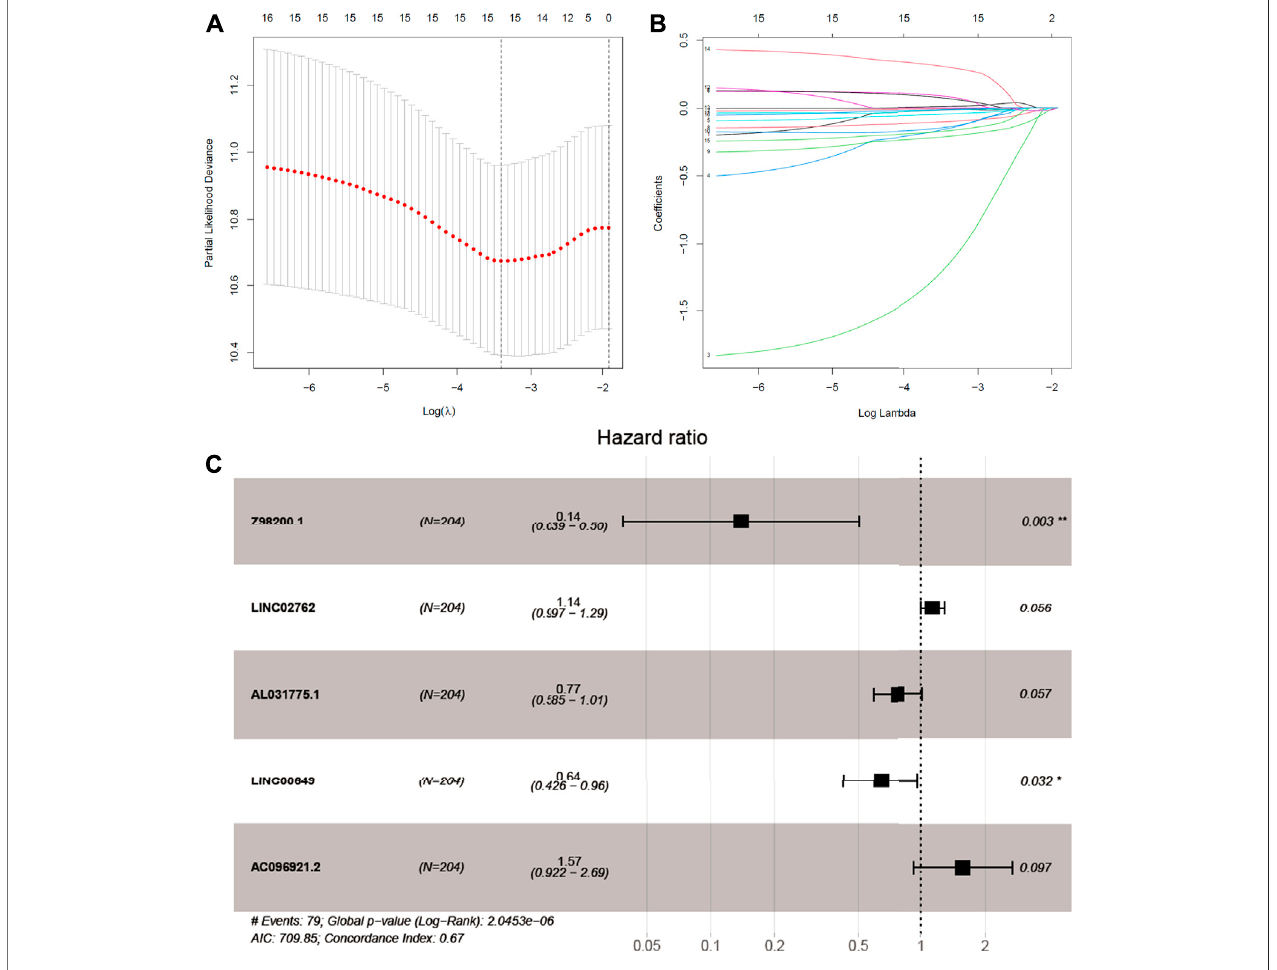
FIGURE 3 | Identifcation of ferroptosis-prognosis – related lncRNAs. (A,B) LASSO regression analysis selected ferroptosis-prognosis – related lncRNAs. (C) Multivariate Cox regression analysis to identify independent risk factors for bladder cancer.